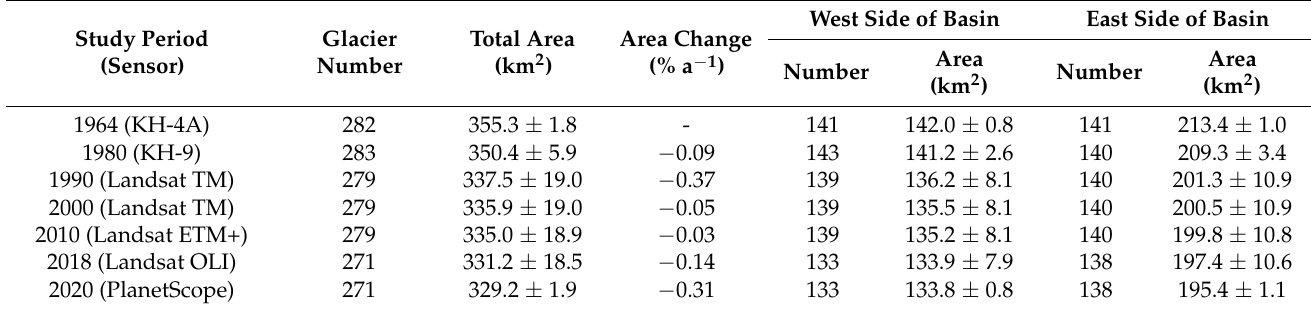
Table 1. Glacier inventories between 1964 and 2020 of the Tama Koshi